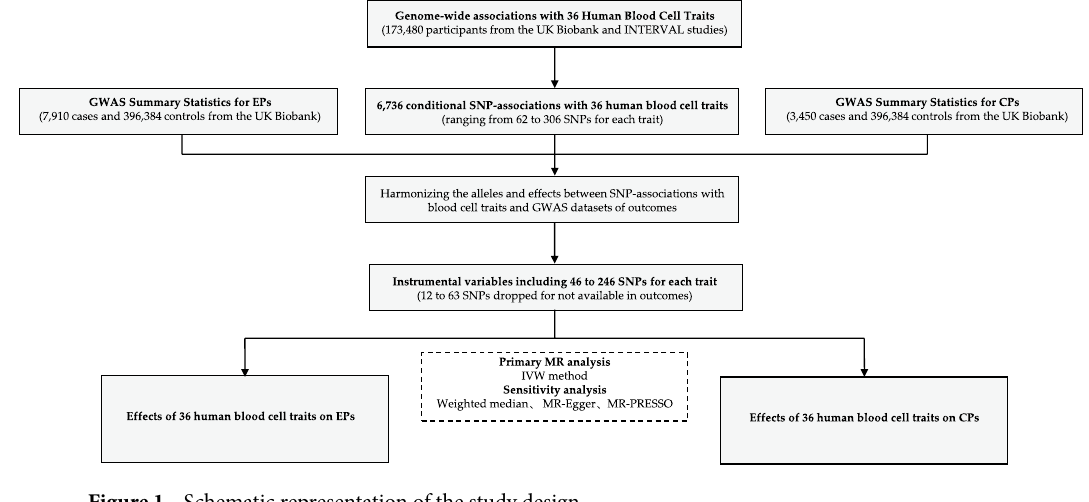
Figure 1. Schematic representation of the study